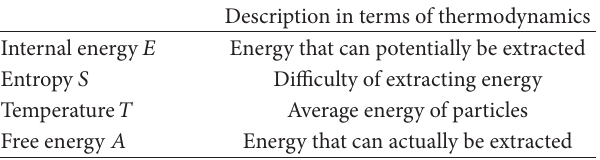
Table 1: Interpretation from the thermodynamic